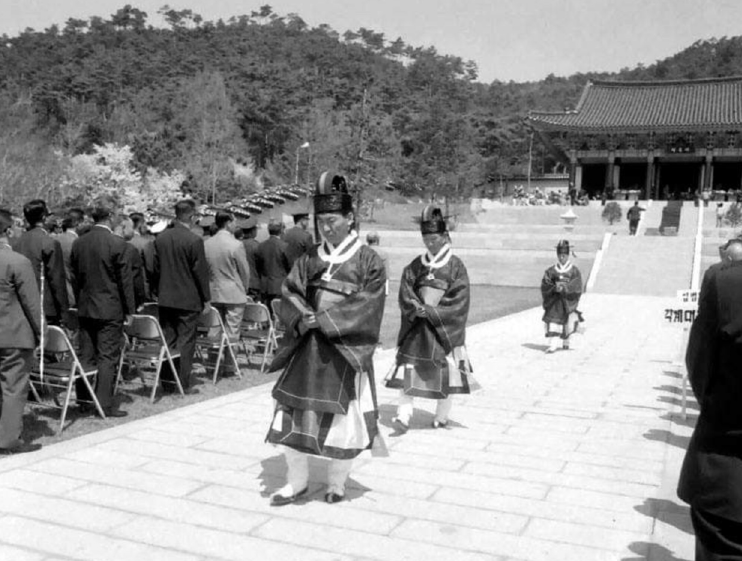
Figure 17. Celebration of Admiral Yi Sun-sin’s Birthday in 1969 (source: National Archives of Ko- rea).